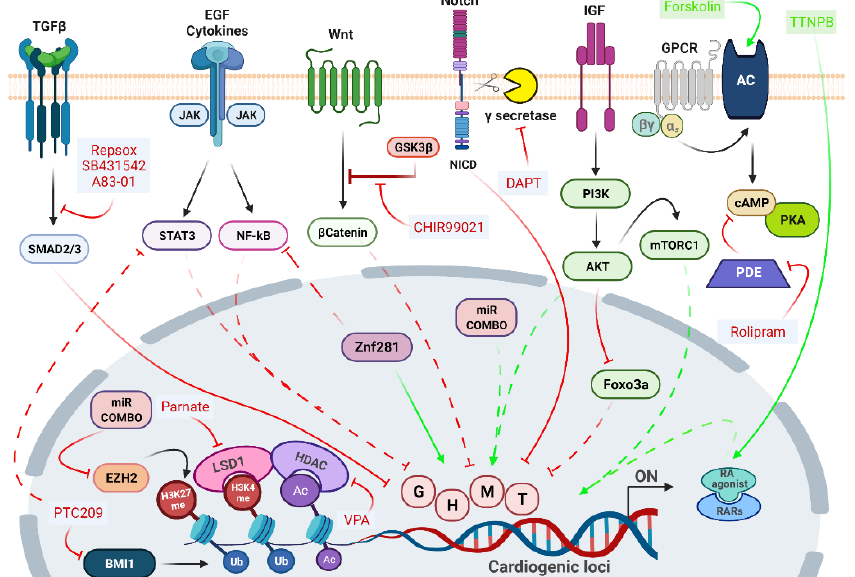
Figure 2. Molecular mechanisms involved in DCR. Green arrows indicate pathways that enhance reprogramming, while green text indicates molecules that activate the relative target. Red arrows indicate pathways that negatively regulate reprogramming, while red text indicate molecules that inhibit the relative target. Solid lines indicate direct interactions. Dashed lines indicate indirect interactions. Adenylyl Cyclase (AC); Notch Intracellular Domain (NICD); Retinoic Acid Receptor (RAR); miR-1, miR-208, miR-133, miR499 (miR Combo); Gata4 (G); Hand2 (H); Mef2c (M); Tbx5 (T); ubiquitylation on Lys119 (Ub); histone H3 Lys4 methylation (H3K4me); histone H3 Lys27 methylation (H3K27me); histone 3 Lys 27 acetylation (Ac). The figure is created with BioRender.